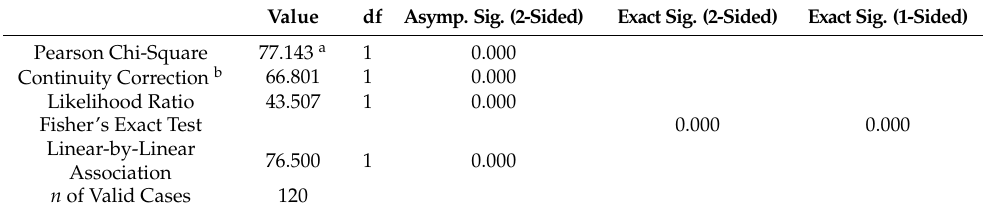
Table 3. Result for Chi-Square